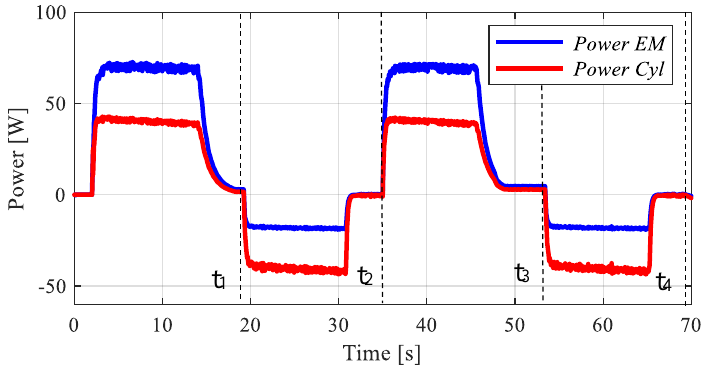
Figure 9. Instantaneous power during the cycle.